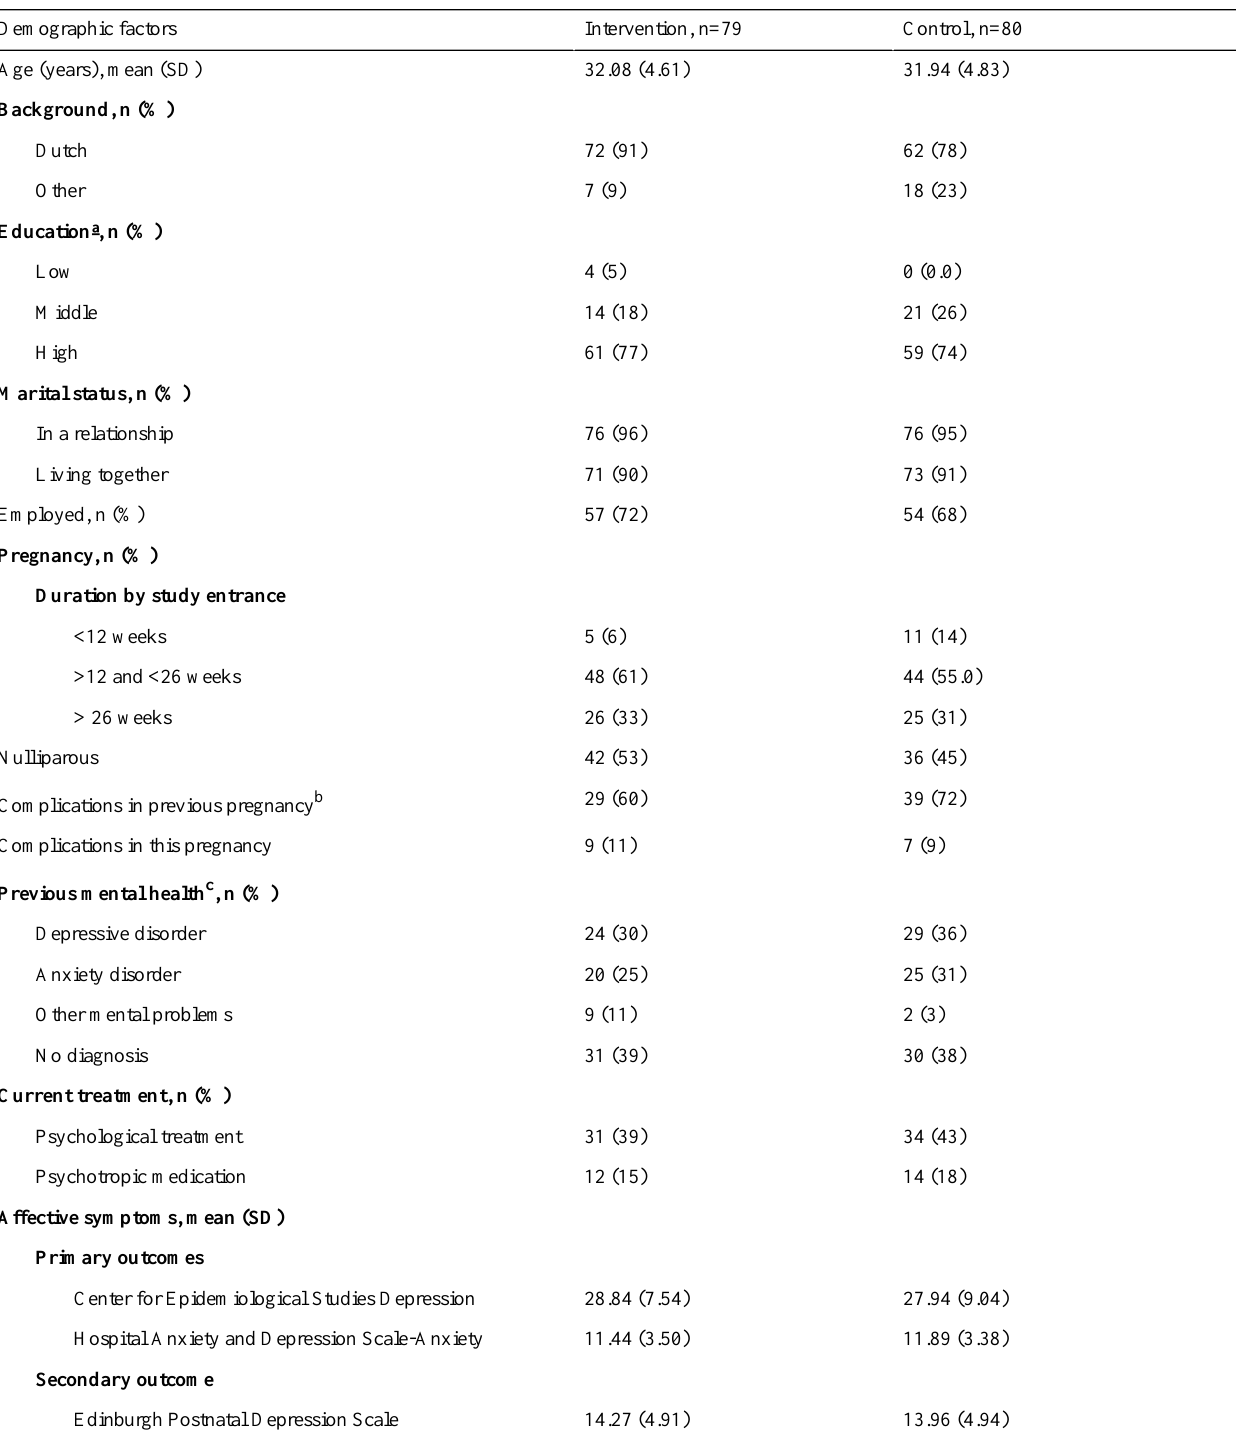
Table 1. Sociodemographic and clinical characteristics at baseline for the intervention group and the control group (primary and secondary outcomes).